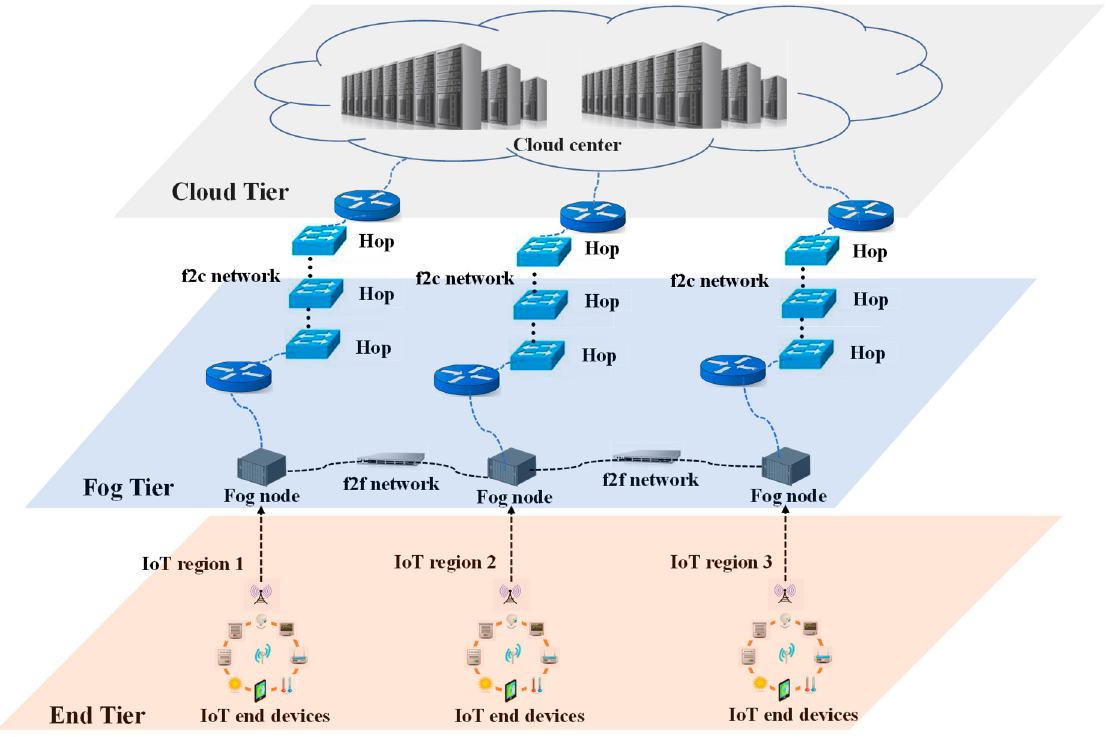
Figure 1. Internet of things (IoT)-fog-cloud system architecture.